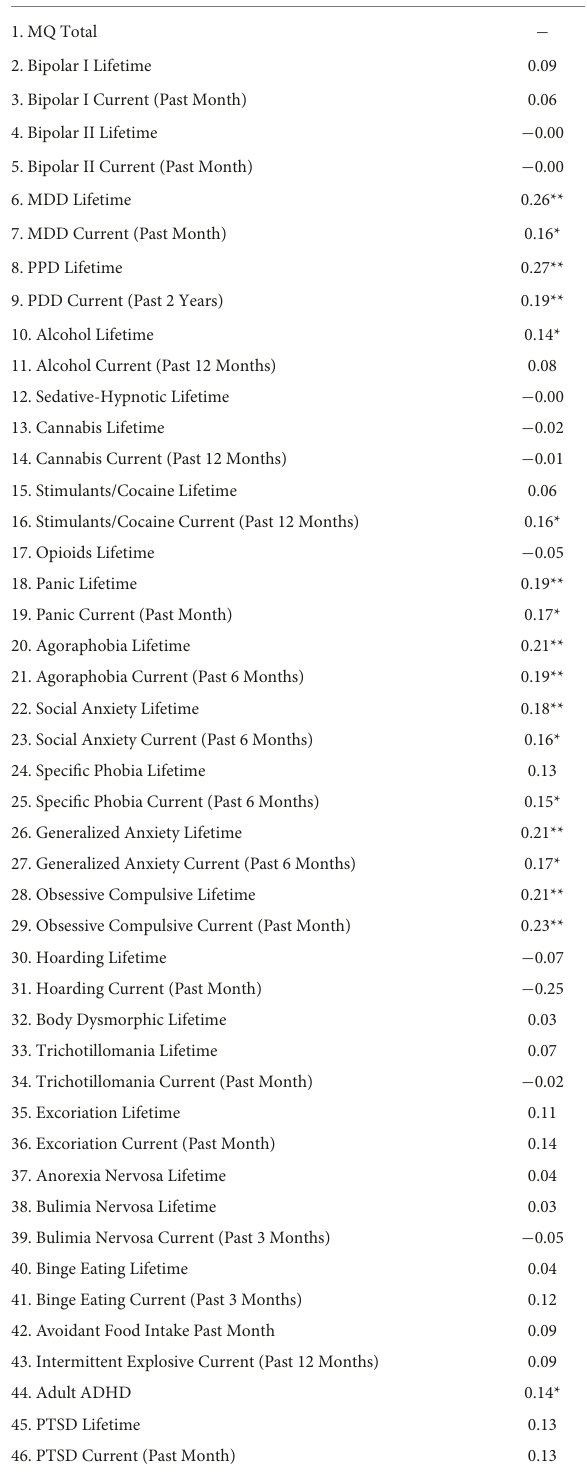
TABLE 3 Pearson’s correlations between total score on the Misophonia Questionnaire (MQ) and specific DSM-5 psychiatric